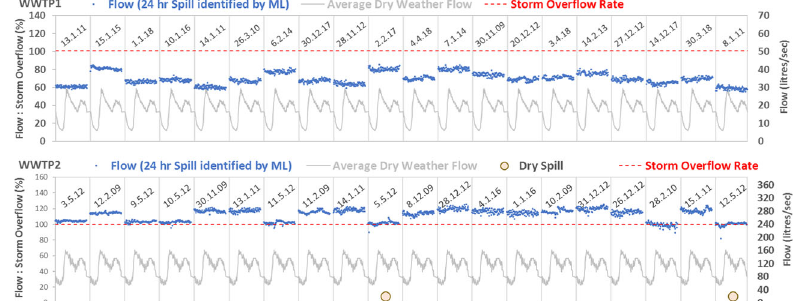
Fig. 5 The 20 daily ef fl uent fl ows most fl attened by 24-h spilling compared to the average daily dry. Weather fl ow For WWTP1, each spill last 24-h during which the ef fl uent rate is between 60% and 80% of the storm over fl ow rate. For WWTP2, in contrast, the ef fl uent rate is at or above the corresponding storm over fl ow rate. Also, two 24-h spills (5.5.12 and 12.5.12) are highlighted as “ Dry Spills ” because there was no rainfall on the day they occurred nor on the previous